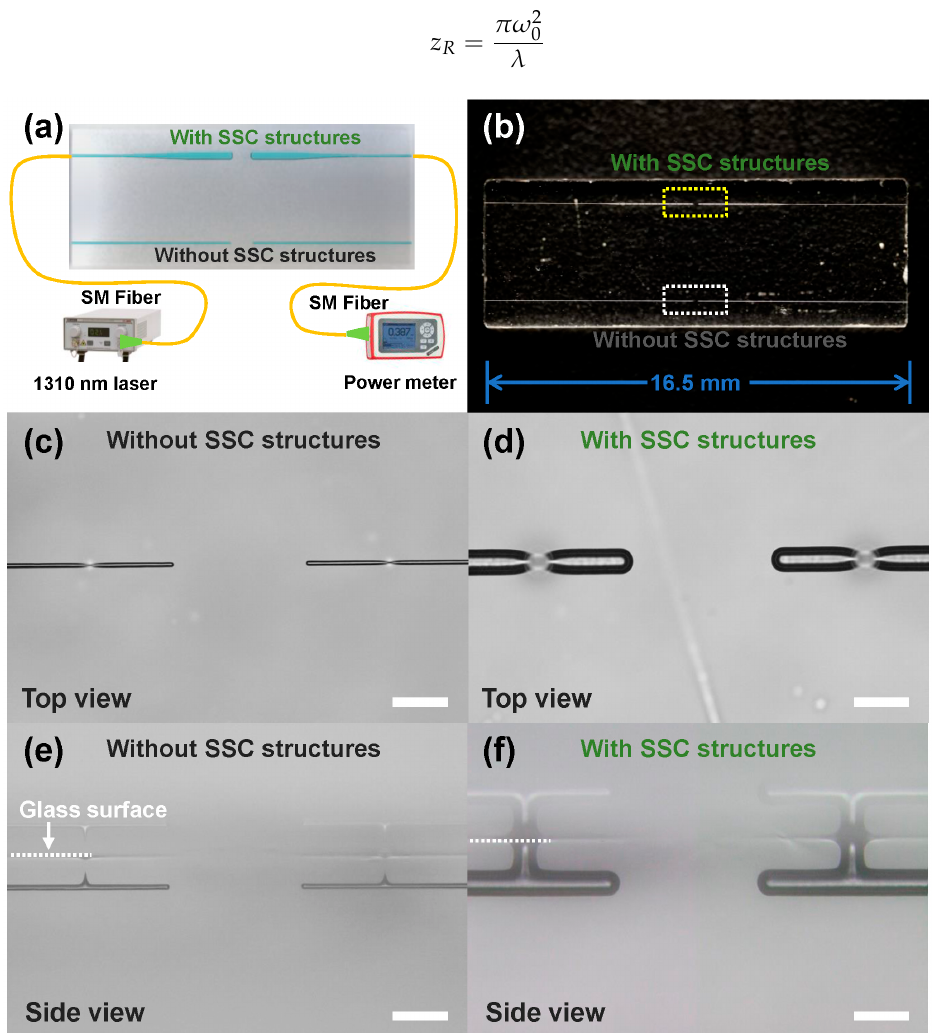
Figure 4. ( a ) Schematic of the experimental setup for the coupling loss measurement of optofluidic devices with and without SSC structures. ( b ) Photograph of a glass microchannel sample including symmetric SSC and non-SSC channel structures with an interval of 250 μ m. ( c ) Top-view and ( e ) side-view optical micrographs of the coupling terminals of two ~9 μ m-diameter non-SSC structures, which are indicated by a dashed white rectangle in ( b ). ( d ) Top-view and ( f ) side-view optical micrographs of the coupling terminals of two ~50 μ m-diameter SSC structures, which are indicated by a dashed yellow rectangle in ( b ). White dashed lines in ( e , f ) indicate the glass surface. The scale bars in ( c – f ) represent 100 μ m.